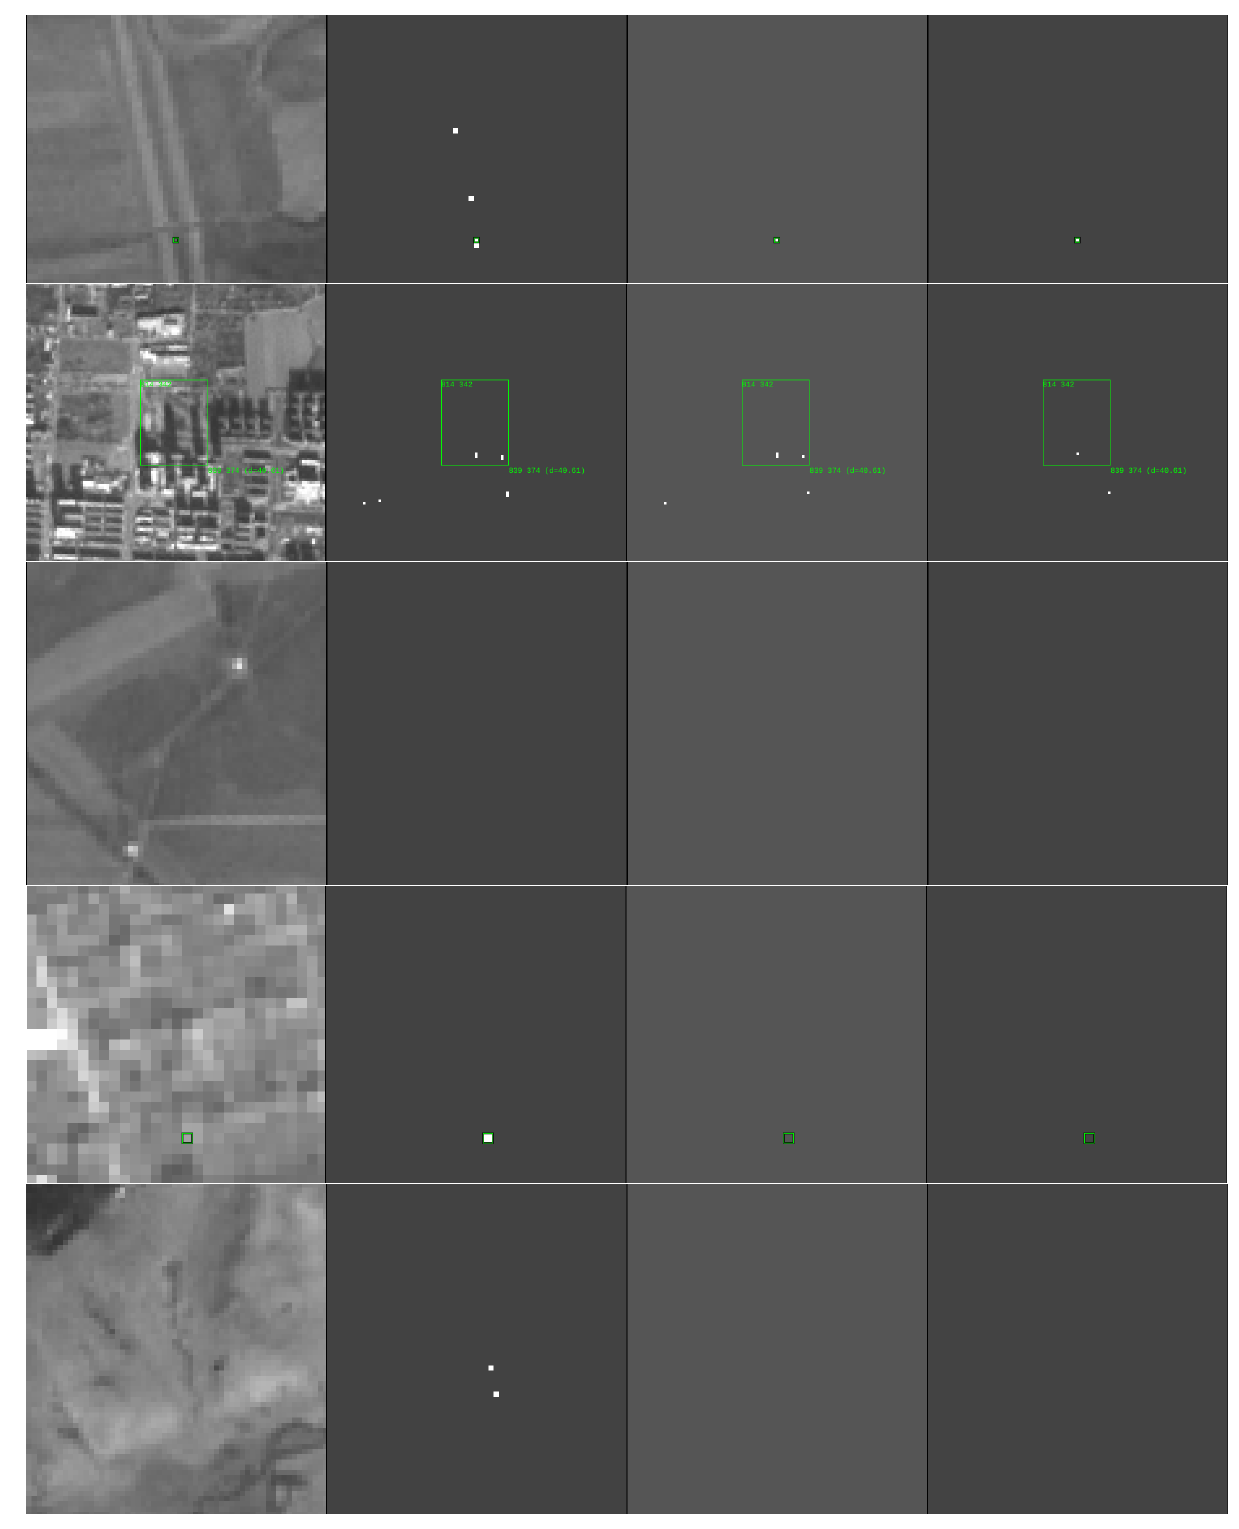
Figure 8. Bad results of multidate detection. The first column is the Sentinel-2 scene, the second one is the final detection map with ϵ = 1 , the third one is the detection map with ϵ = 0 . 1 , the final one is the detection map with ϵ = 0 . 01 . Each row shows a different example. On the detection maps, white pixels are detections, black ones are not. On some of the rows, a rectangular green box is drawn to ease the matching between the